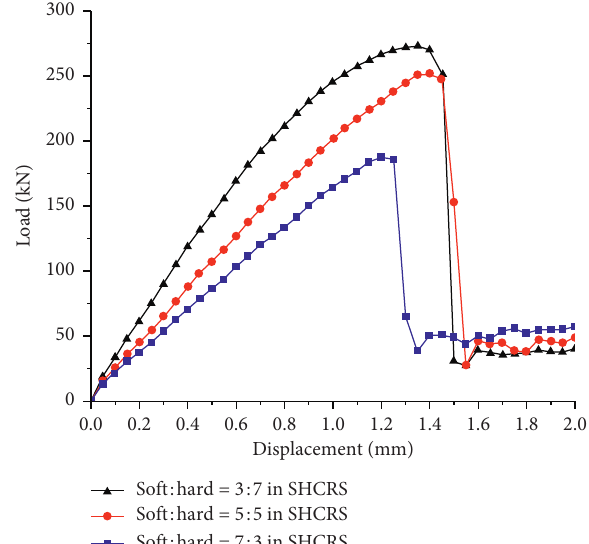
Figure 14: Comparison of load-displacement curves of soft-to-hard thickness ratios (3: 7, 5 :5, and 7:3) in